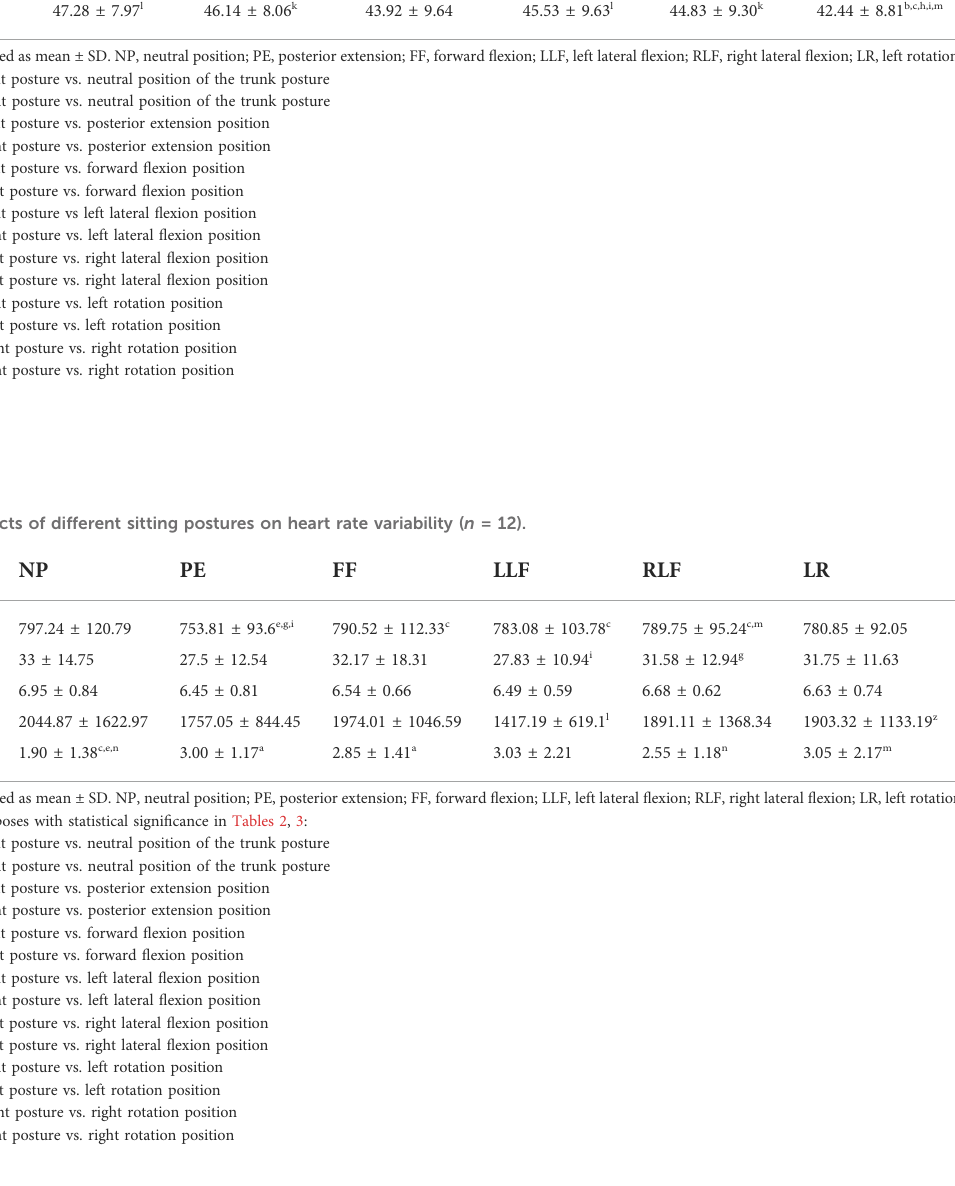
Data are expressed as mean ± SD. NP, neutral position; PE, posterior extension; FF, forward fl exion; LLF, left lateral fl exion; RLF, right lateral fl exion; LR, left rotation; RR, right rotation. a p < 0.05 current posture vs. neutral position of the trunk posture b p < 0.01 current posture vs. neutral position of the trunk posture c p < 0.05 current posture vs. posterior extension position